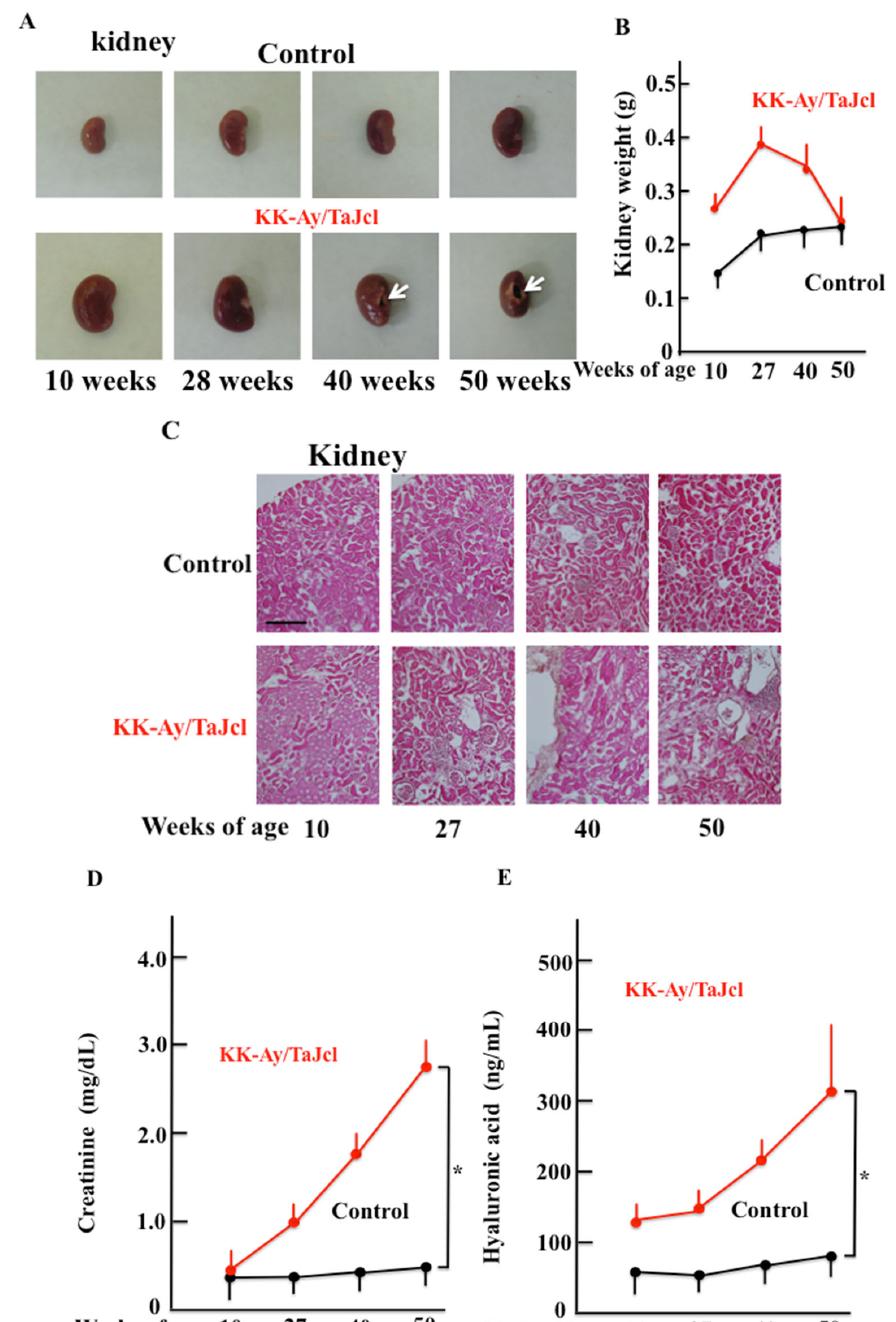
Figure 4. Effect of aging on kidney condition ( A ), kidney weight ( B ), histological analysis (hematoxylin–eosin staining) ( C ), and blood levels of creatinine ( D ) and hyaluronic acid ( E ) in the dorsal skin of KK-Ay/TaJcl mice. White arrows ( A ) indicate the site of kidney injury. The data show one repre ‐ sentative experiment using five animals. Scale bar = 100 μ m. Values are expressed as mean ± SD derived from five animals. * p < 0.05. Control: C57BL/6j mice.